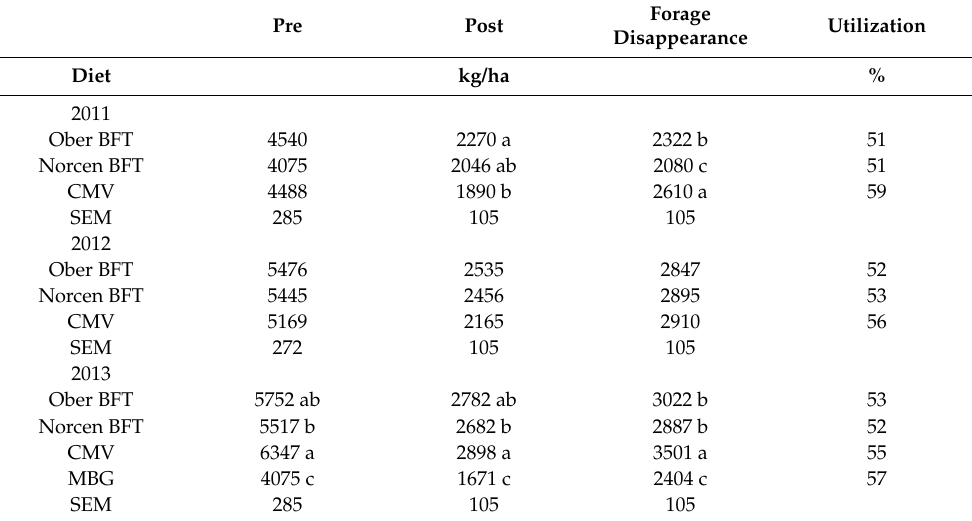
Table 1. LSMEANS of season-long forage dry matter (DM) measured before (pre) and after (post) grazing, forage disappearance, calculated as the difference between pre- and post-grazing DM, and pasture